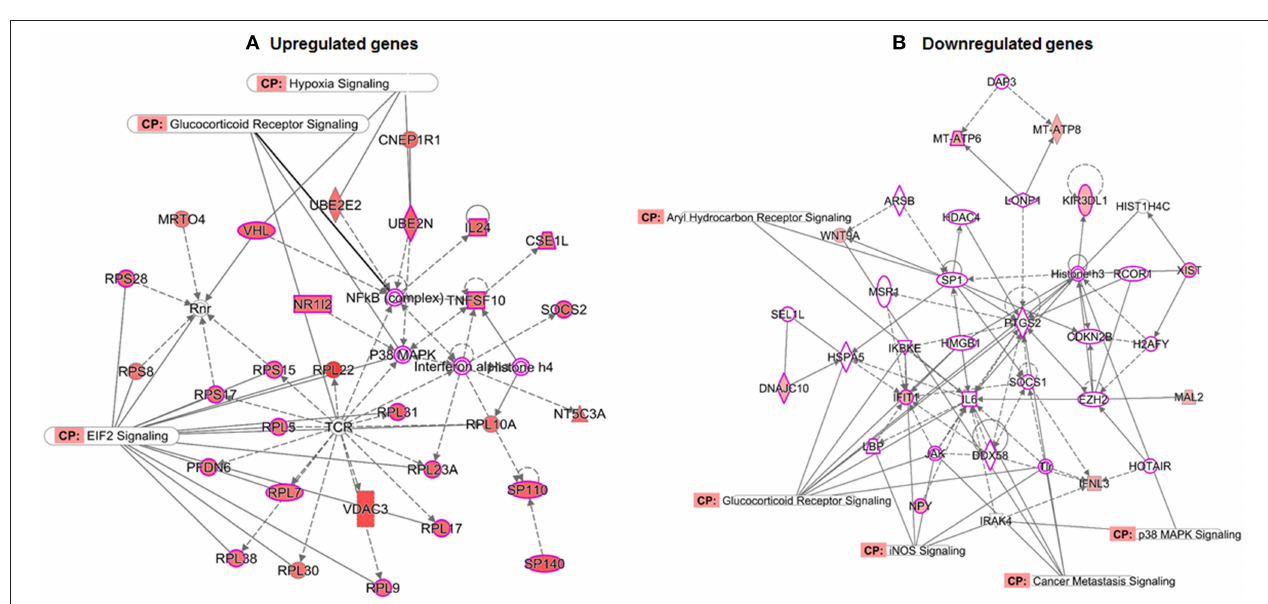
FIGURE 6 | Gene networks and canonical pathways generated by Ingenuity Pathway Analysis. (A) Upregulated gene network (B) downregulated gene network including proteins and enzymes, G-protein coupled receptors and different regulators and receptors compared between TRAMP mice and non-transgenic littermates. Solid and dotted lines imply direct and indirect relationships between proteins. The intensity of the node color (red) indicated the degree of upregulation and pink color is designated as cancer associated molecules/pathways. The node shapes denote enzymes, phosphatases, kinases, peptidases, G-protein coupled receptor, transmembrane receptor, cytokines, growth factor, ion channel, transporter, translation factor, nuclear receptor, transcription factor.